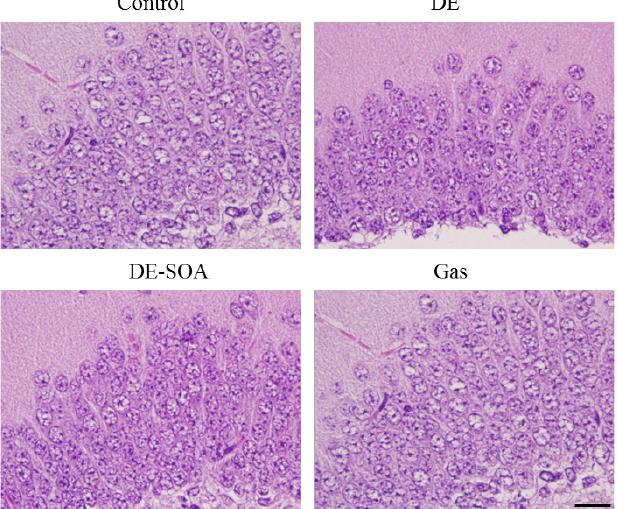
Figure 7. Representative photomicrographs showing the histology of CA1 area of the hippocampi in the control, DE-, DE-SOA-, and gas-exposed preweaning mice. Scale bar = 50 μ